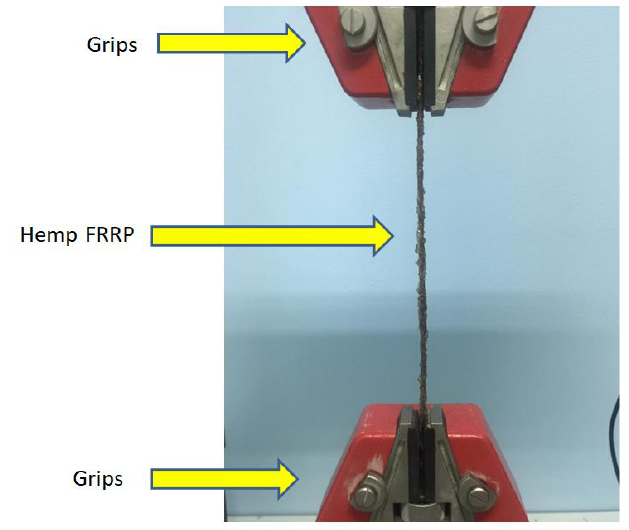
Figure 4. Test setup of hemp FRRP.